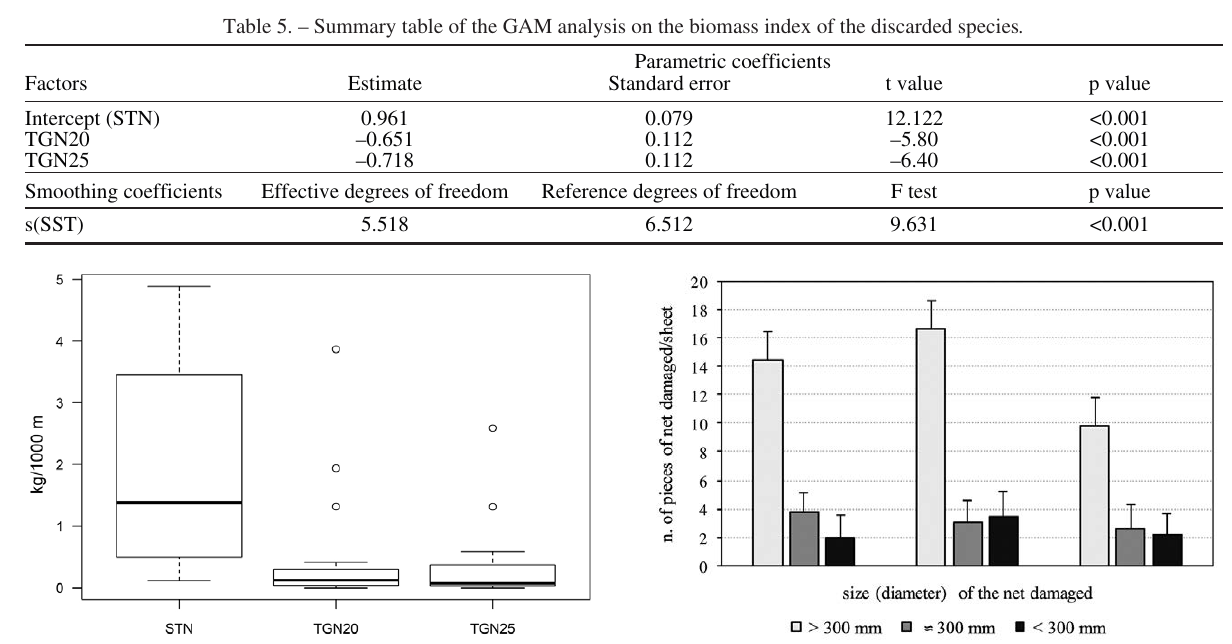
Fig. 9. – Number of pieces of net damaged (average value per sheet Fig. 7. – Box-plot of the biomass indices (kg/1000 m of net) of the of net), according to the three types of net. Data were recorded at discarded species for the three nets. The lower and higher lines of the end of the experimental the boxes are the first and the third quantile, respectively; the bold line is the median and the dotted lines delimit the minimum and maximum values excluding outliers.